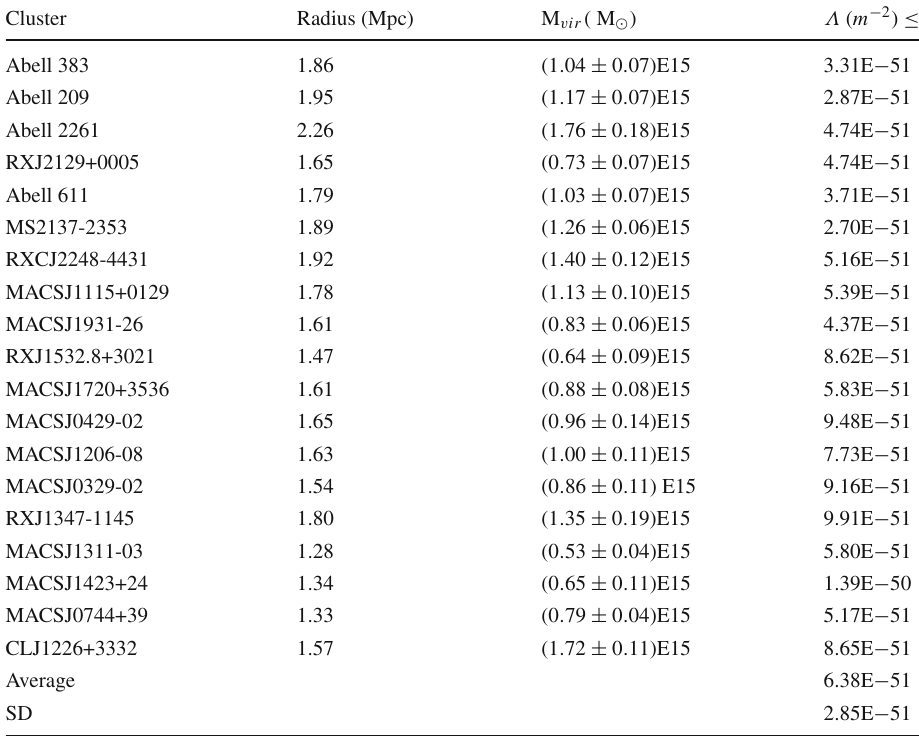
Table 9 Error limit of Λ for CLASH